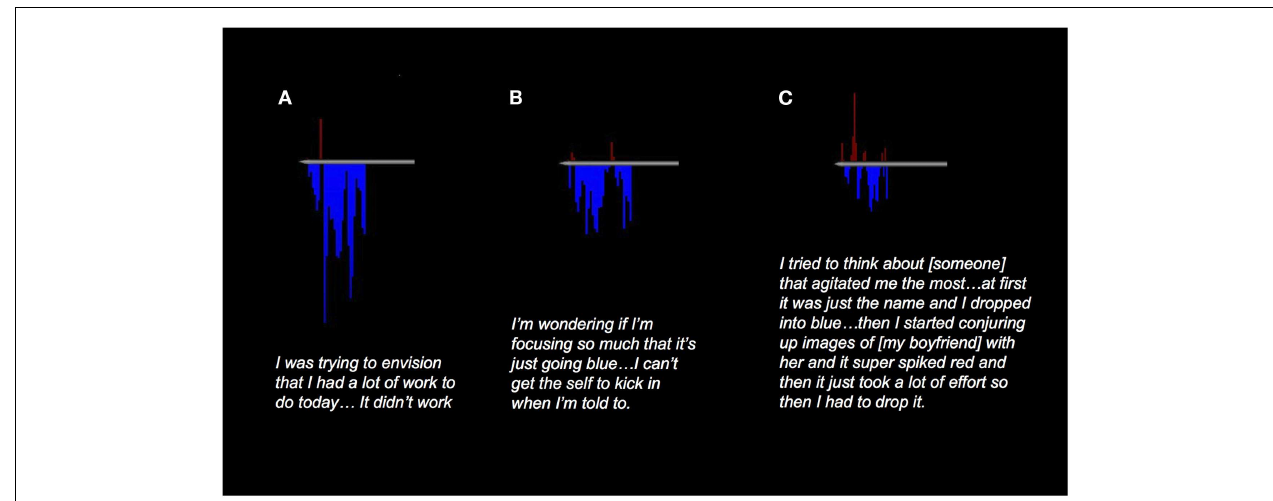
FIGURE 1 | Examples of real-time neurofeedback from the PCC in meditators . Graphs show percent signal change in the PCC relative to an active baseline task. (A) “I was trying to envision that I had a lot of work to do today ... It didn’t work.” (B) “I decided to picture wedding plans and so I started off thinking about my wedding and how I wanted to look good and then it just started to go blue. I switched to babies and I thought, ‘I want babies’ and I think that might correlate with a little red blip but then I couldn’t sustain it ... I’m wondering if I’m focusing so much that it’s just going blue because I’m focusing but I can’t get, I can’t get the self to kick in when I’m told to.” (C) “I tried to think about